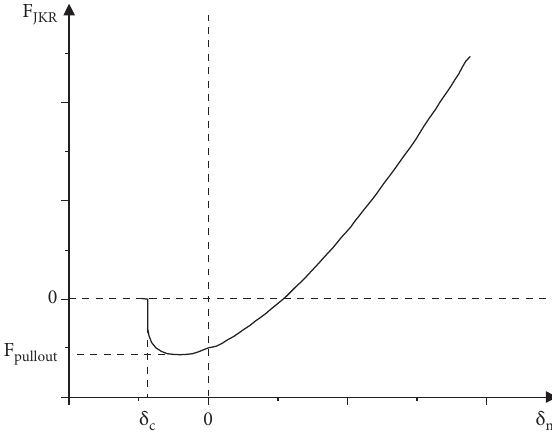
Figure 2: Normal force as a function of normal